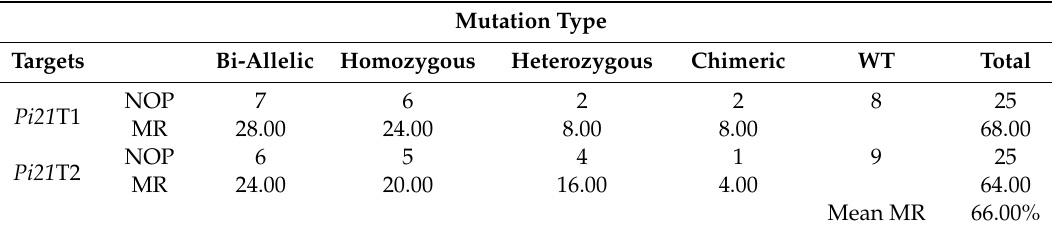
Table 1. Mutation rates of both targets in T 0